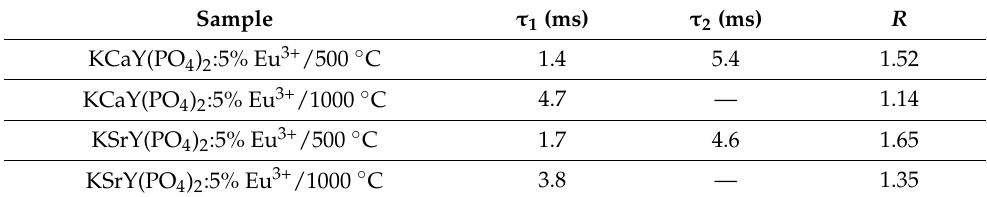
Table 2. The decay time and the R parameter for the K Me Y(PO 4 ) 2 :5% Eu samples. Sample τ 1